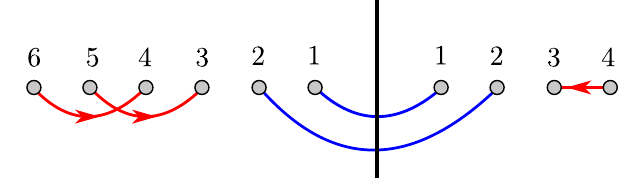
Figure 2 . An example of diagrammatic representation. This term is one of the terms of f 6 ; 4 . Here n is the number of replica and D are the defect matrix M;N